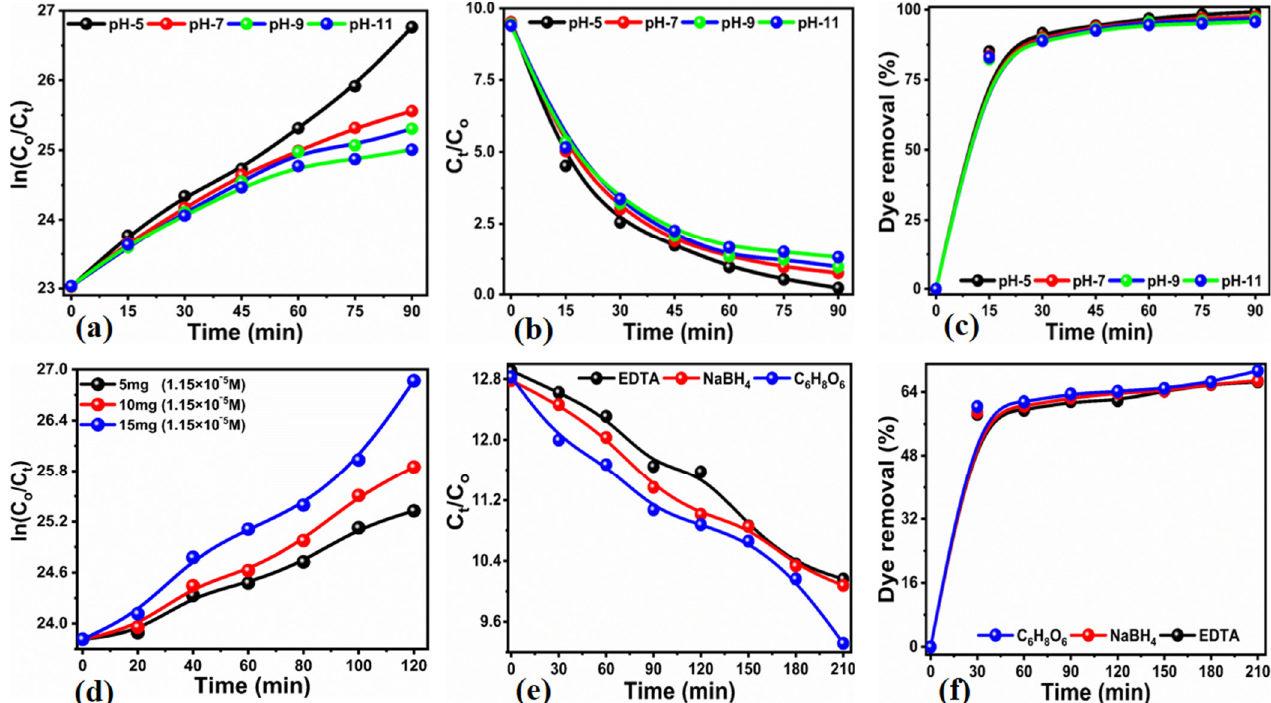
Figure 6. ( a – d ) UV-visible absorbance spectra measured in 2.3 × 10 −5 M MB solution with an adjusted pH of 5, 7, 9 and 11, using 15 mg of as-prepared carbon material under the irradiation of UV for 90 min.